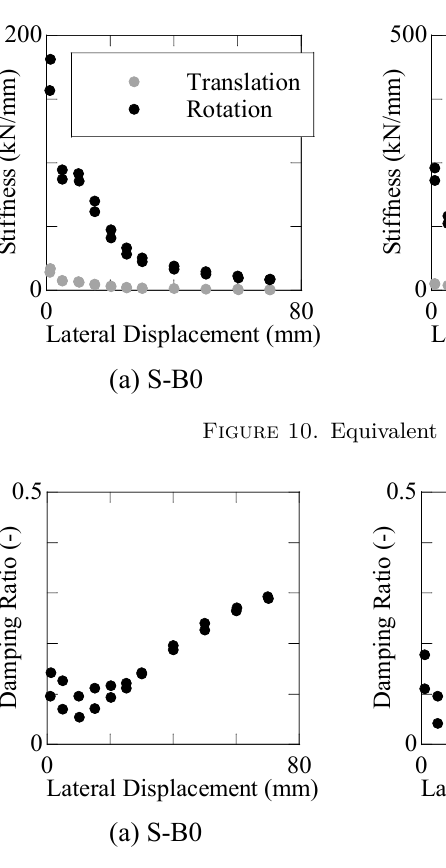
Figure 11. Equivalent damping ratios based on the static loading